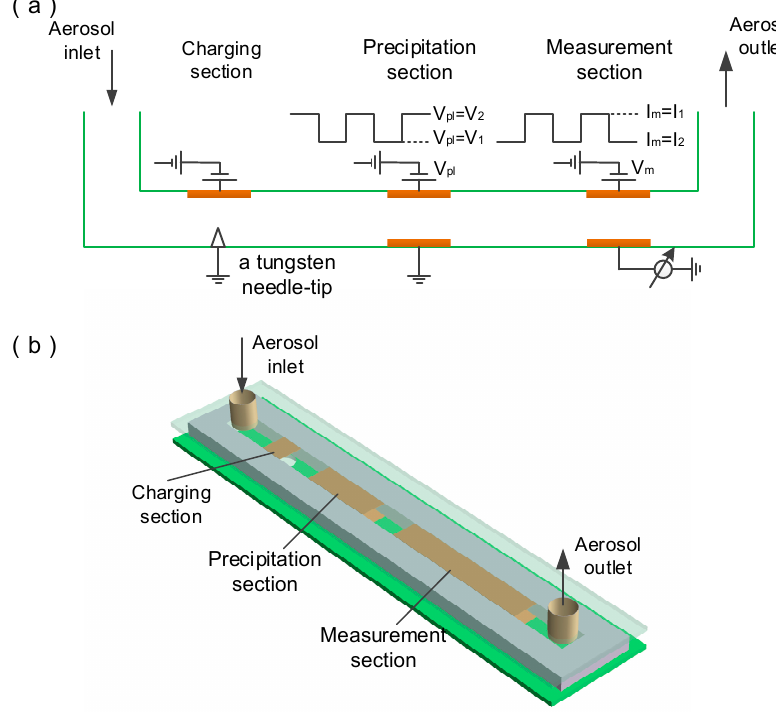
Figure 1. ( a ) The principle structure of the proposed aerosol sensor; and ( b ) Three-dimensional structure model diagram of the proposed aerosol sensor.